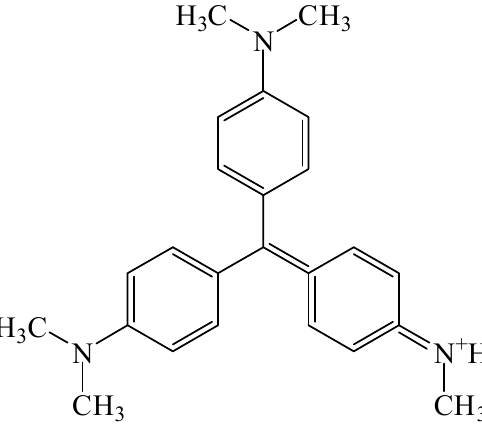
Figure 12. Chemical structure of methyl violet.